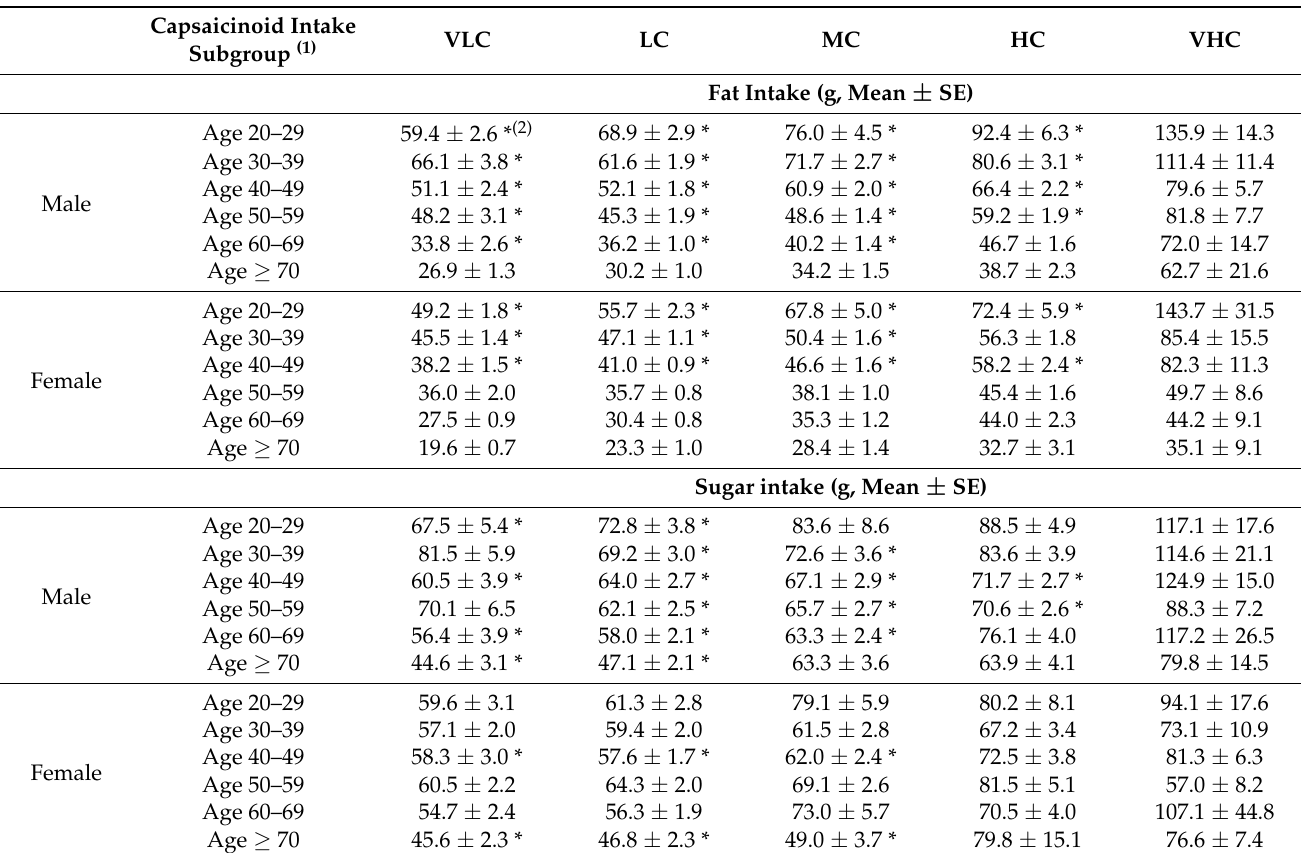
Table 5. Fat and sugar intake levels in the five capsaicinoid intake subgroups in each age and sex group. Capsaicinoid